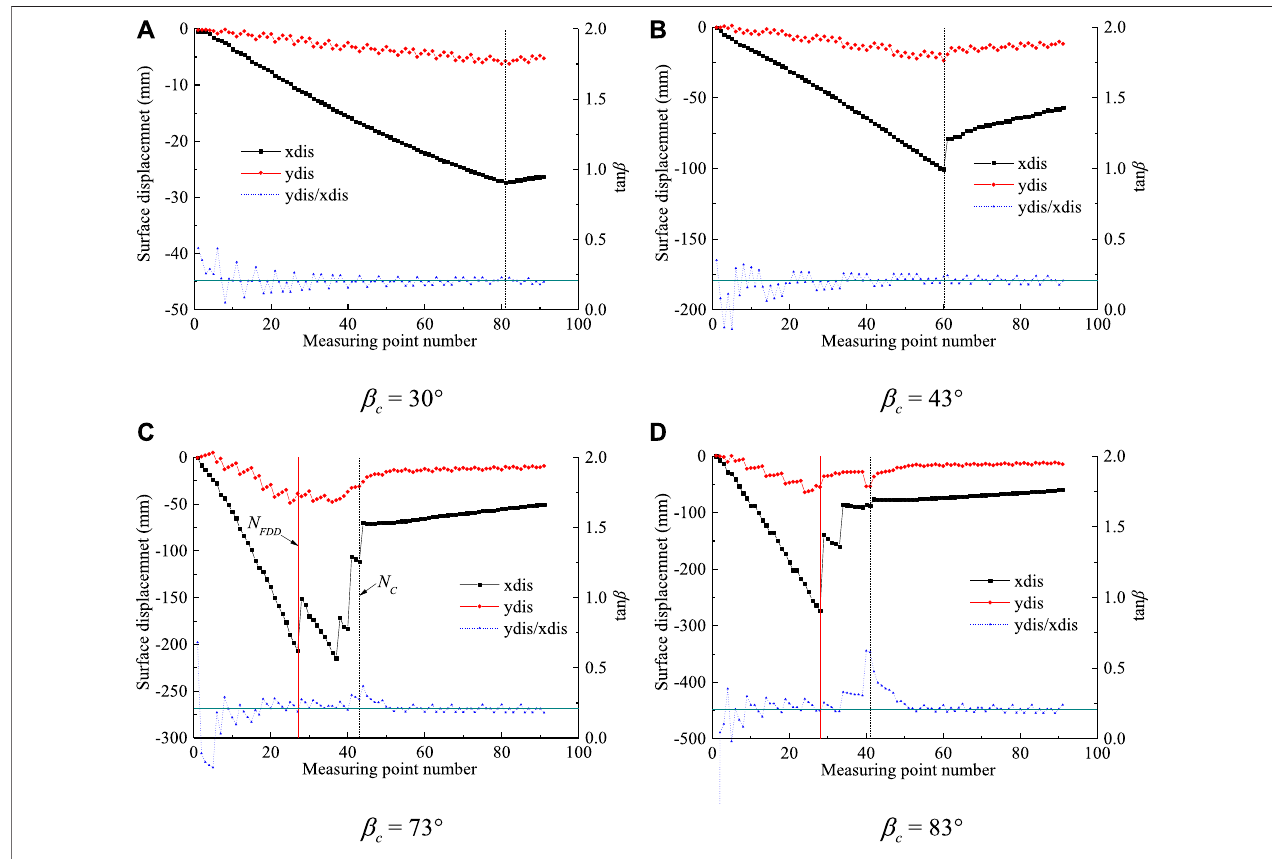
FIGURE 11 | Surface displacement distribution of slope for different slope angles ( β c ). N C and N FDD : Measuring points corresponding to the slope crest and fi rst displacement discontinuity, respectively.